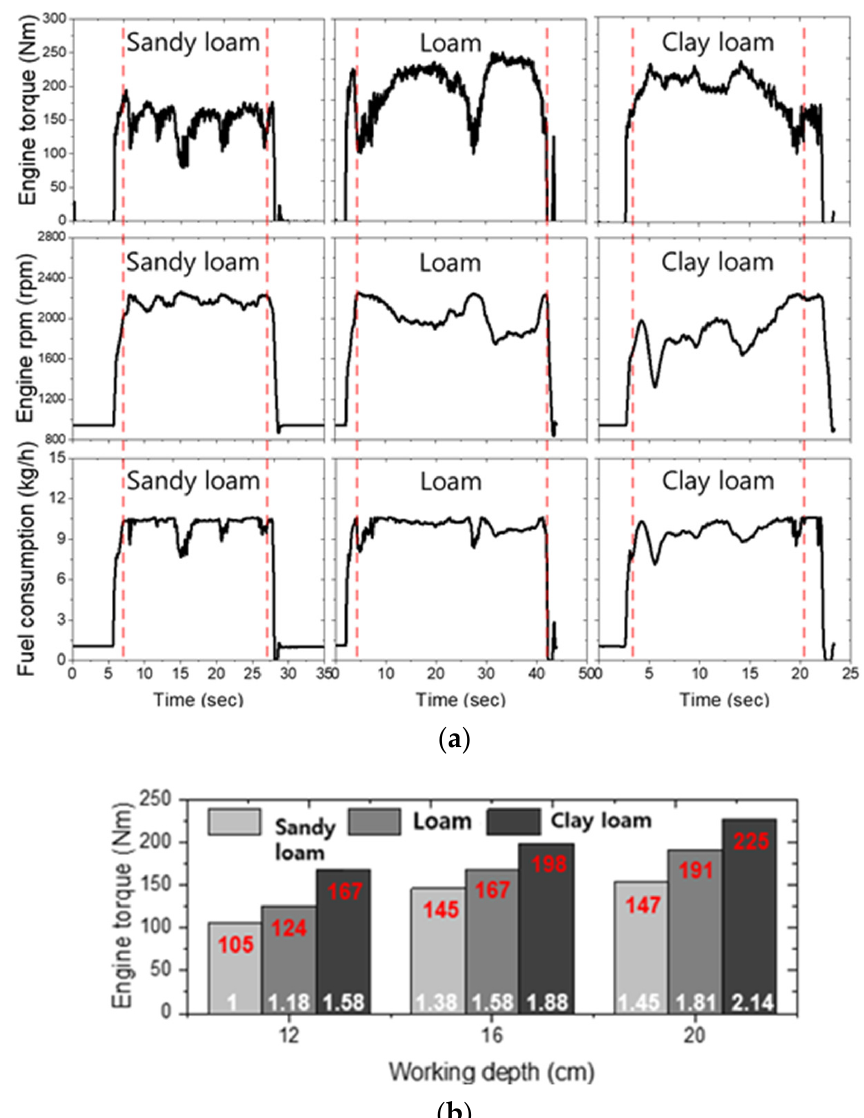
Figure 7. ( a ) Field measurements results of the engine load with fuel consumption under various field sites; ( b ) Comparison analysis of engine torque by tillage depth and test sites.